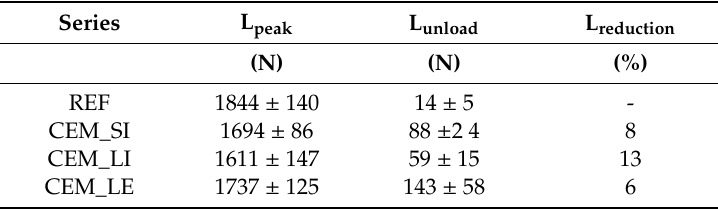
Table 3. Overview of the average L peak and L unload (with respective standard deviation) and L reduction for each series (12 specimens per series) after the pre-cracking